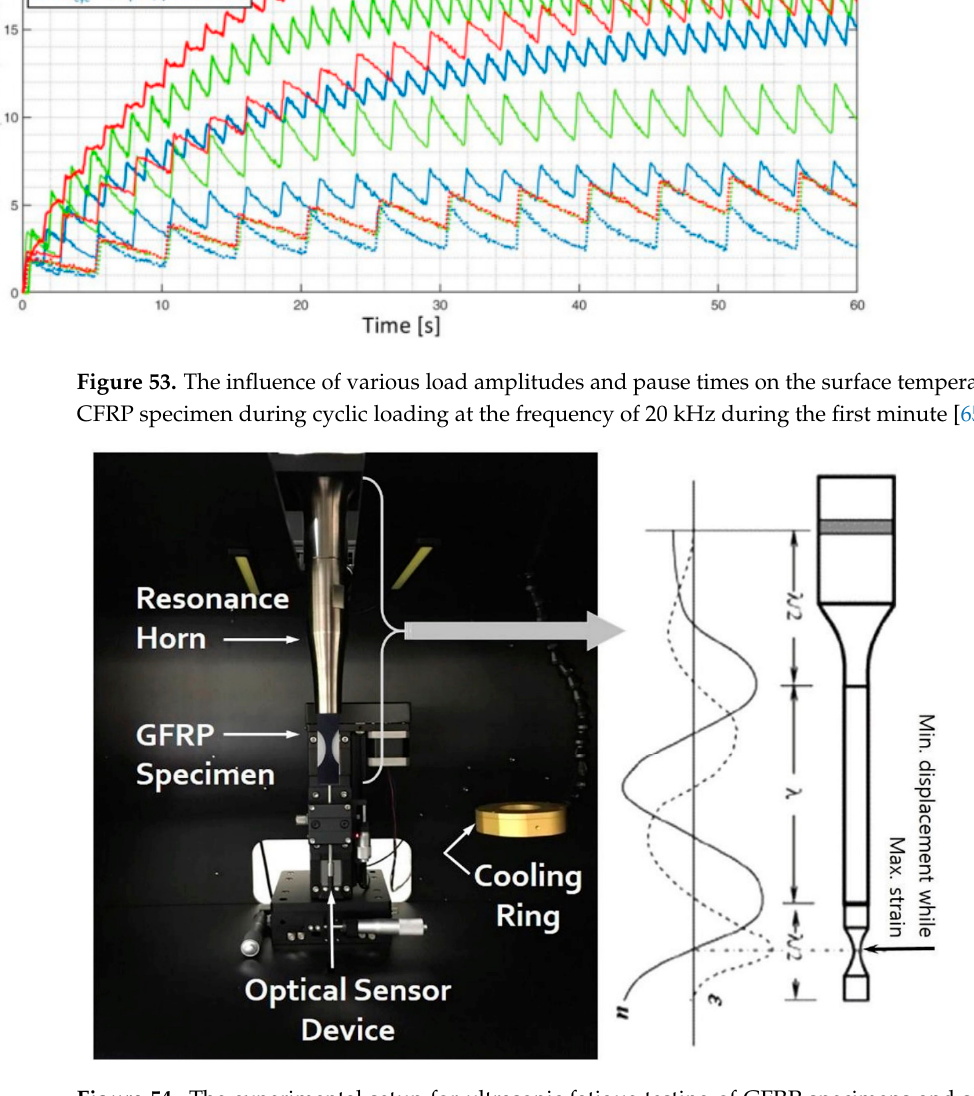
Figure 54. The experimental setup for ultrasonic fatigue testing of GFRP specimens and schematic illustration of resonance test, adapted with permission from Ref. [163]. Copyright © 2019 Elsevier